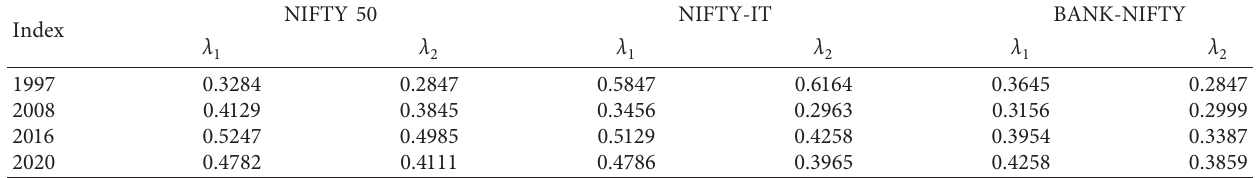
Figure 2: Financial crisis. Table 11: Yearly average prediction error reduction index of NSE